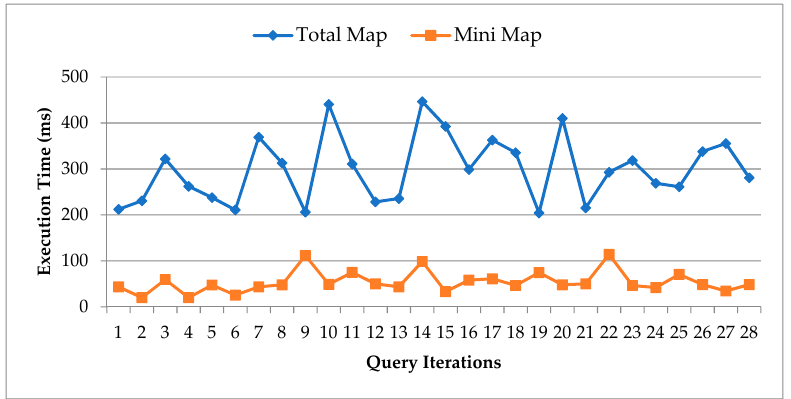
Figure 14. Execution time comparisons for loading of total map vs. mini-map.